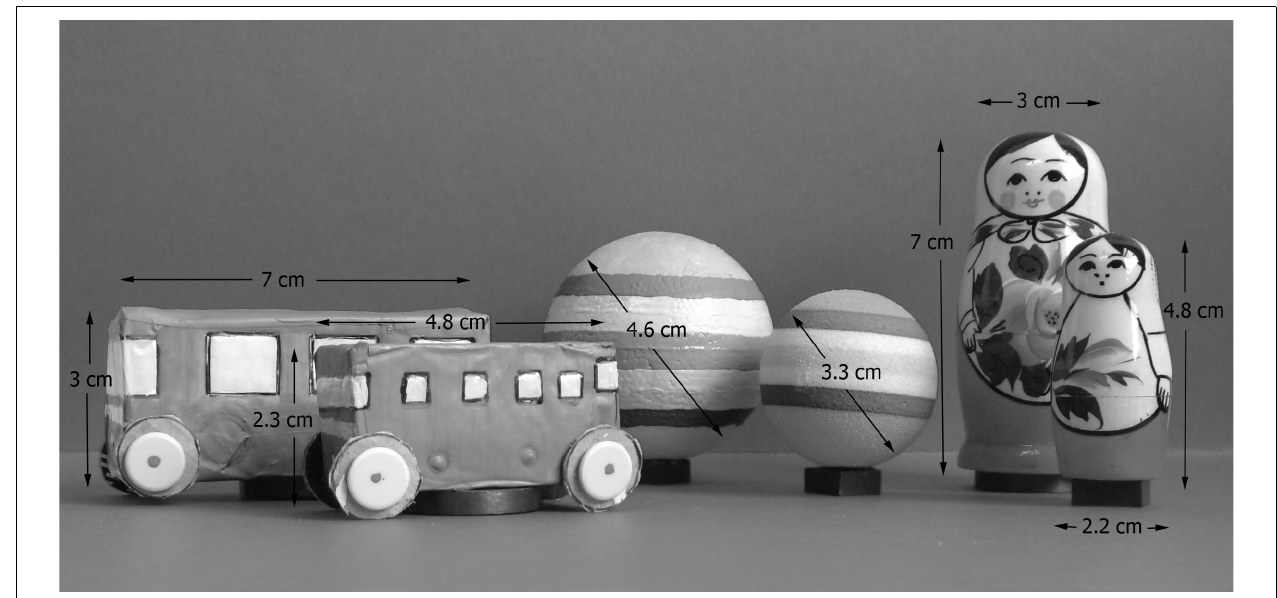
FIGURE 1 | The experimental